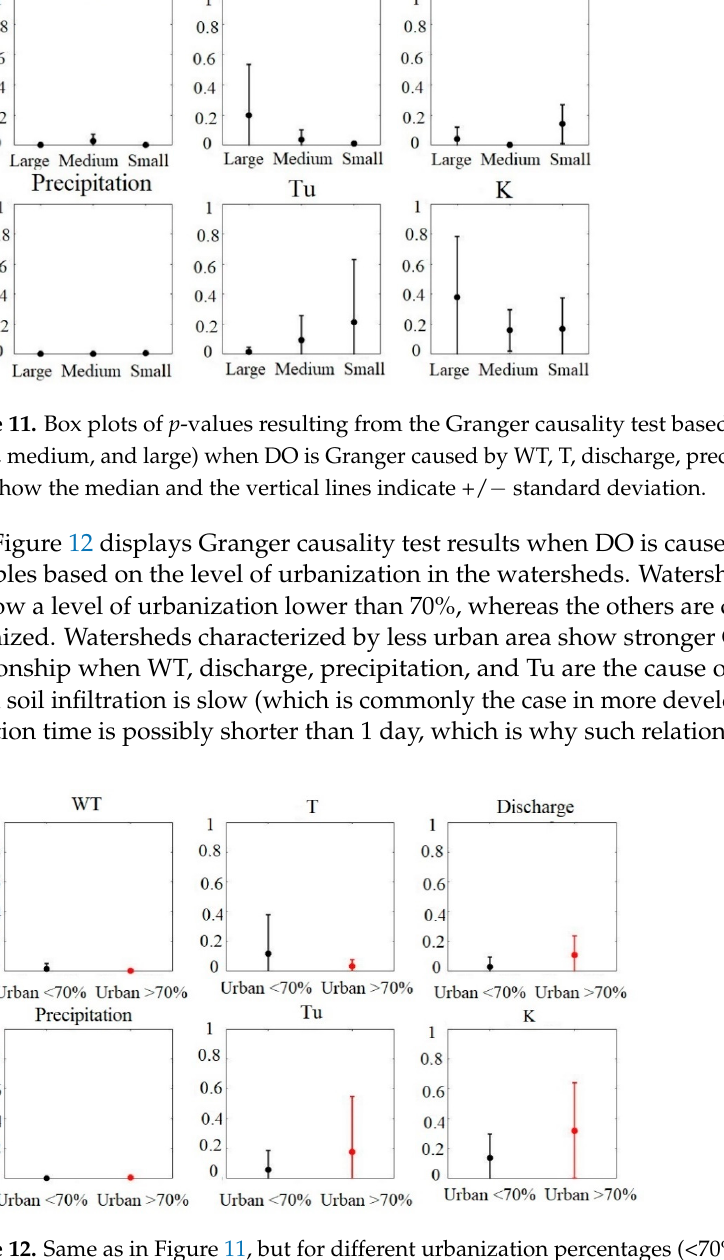
Figure 12. Same as in Figure 11, but for different urbanization percentages (<70% and >70%).